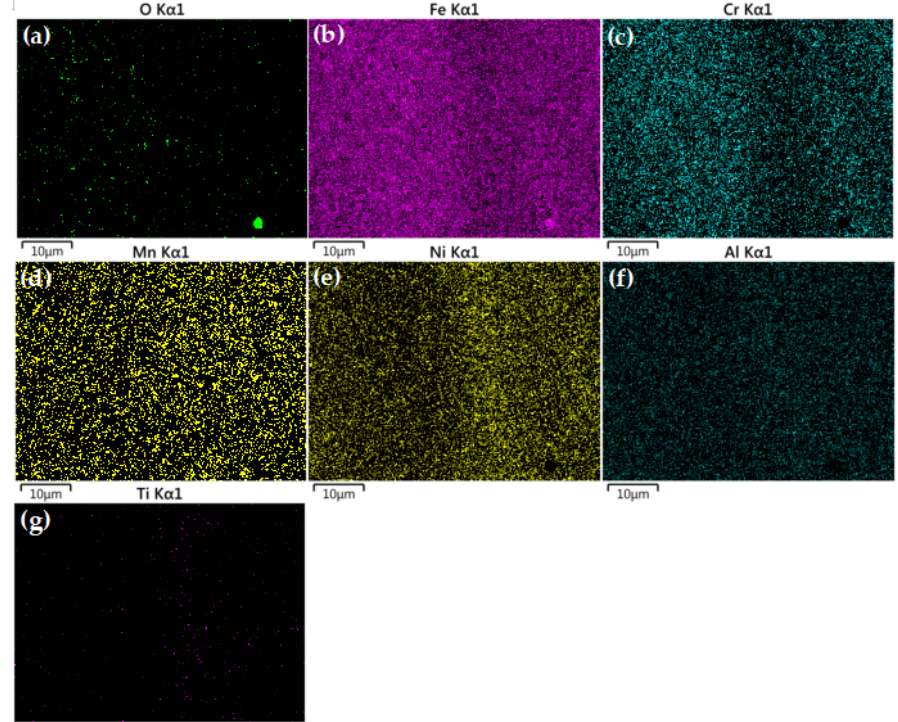
Figure 13. Surface scan of the (FeNi)67Cr15Mn10Al5Ti3 alloy after corrosion in a 400 °C high- temperature and high-pressure water environment for 14 days: ( a ) Distribution diagram of O; ( b ) Distribution diagram of Fe; ( c ) Distribution diagram of Cr; ( d ) Distribution diagram of Mn; ( e ) Distribution diagram of Ni; ( f ) Distribution diagram of Al; ( g ) Distribution diagram of Ti.